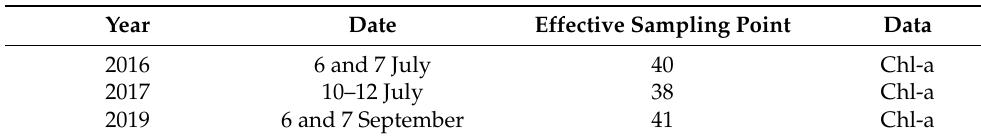
Table 2. Description of the selected sample points. Effective sampling points refer to the number of abnormal points